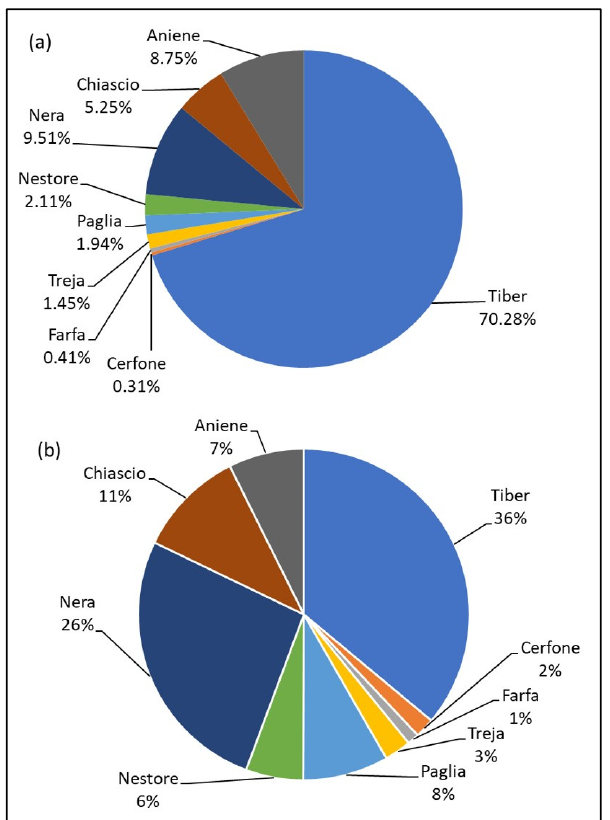
Figure 3. Relative percentages of residential people ( a ) and land extensions ( b ) for each sub- catchment .